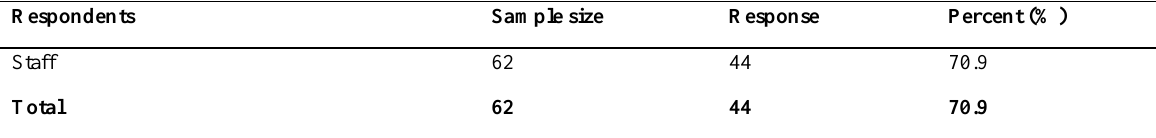
Table 3: Response Rate